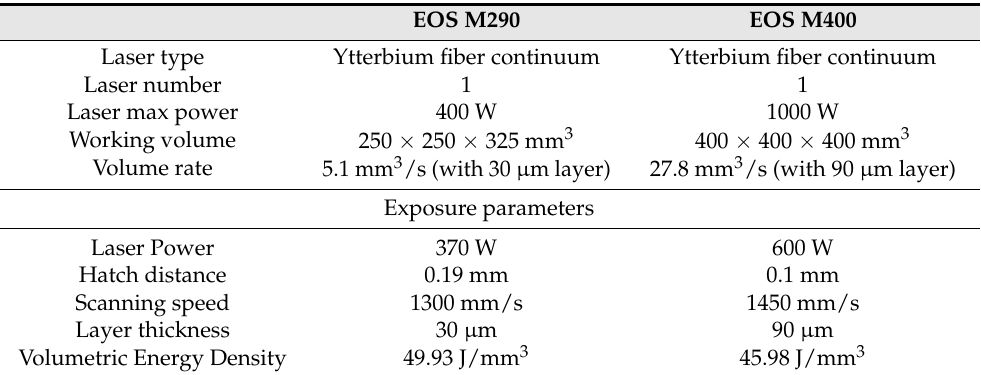
Table 2. Summary of machines characteristics and exposure parameters used for